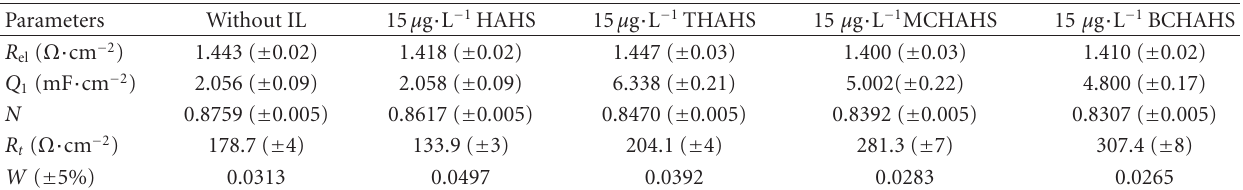
Table 2: Impedance parameters obtained by the FRA4.9 software. Simulated results for as-cast Pb1.6 wt% Sb alloy in a 4.0 MH 2 SO 4 solution with and without 15 µ g · L − 1 ILs at 25 ◦ C.